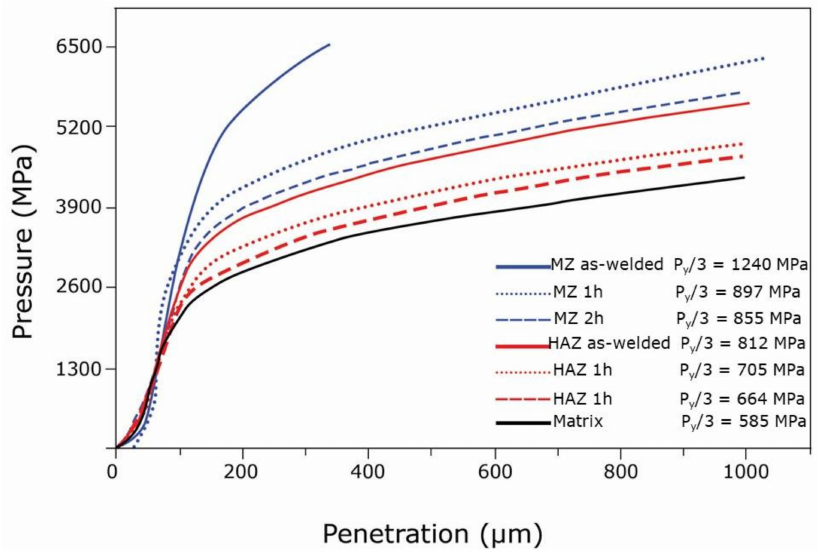
Figure 10. Gas tungsten arc welding (GTAW) joints of Eurofer-97 steel. FIMEC curves obtained from base metal, the HAZ, and the MZ in as-welded condition and after post-welding heat treatments (PWHTs) of 1 and 2 h at 750 ◦ C.